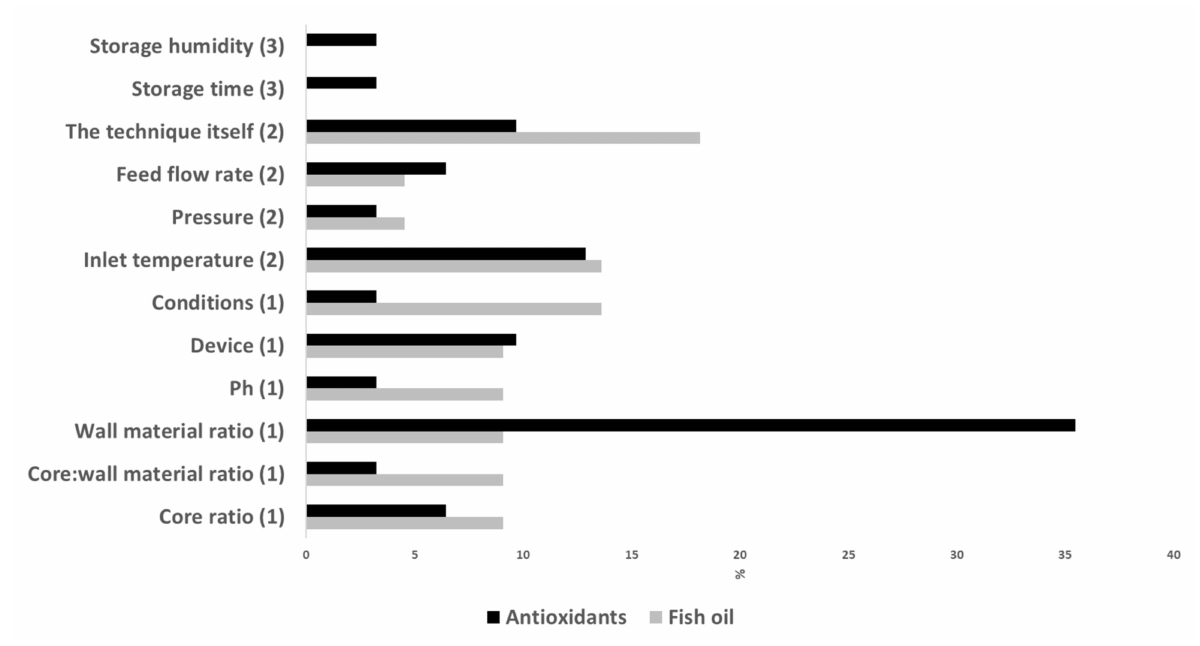
Figure 3. Extent of evaluation of different variables (related to the emulsion/solution preparation (1), the microencapsulation technique (2), and other parameters (3)) for the development of fish oil and natural antioxidant